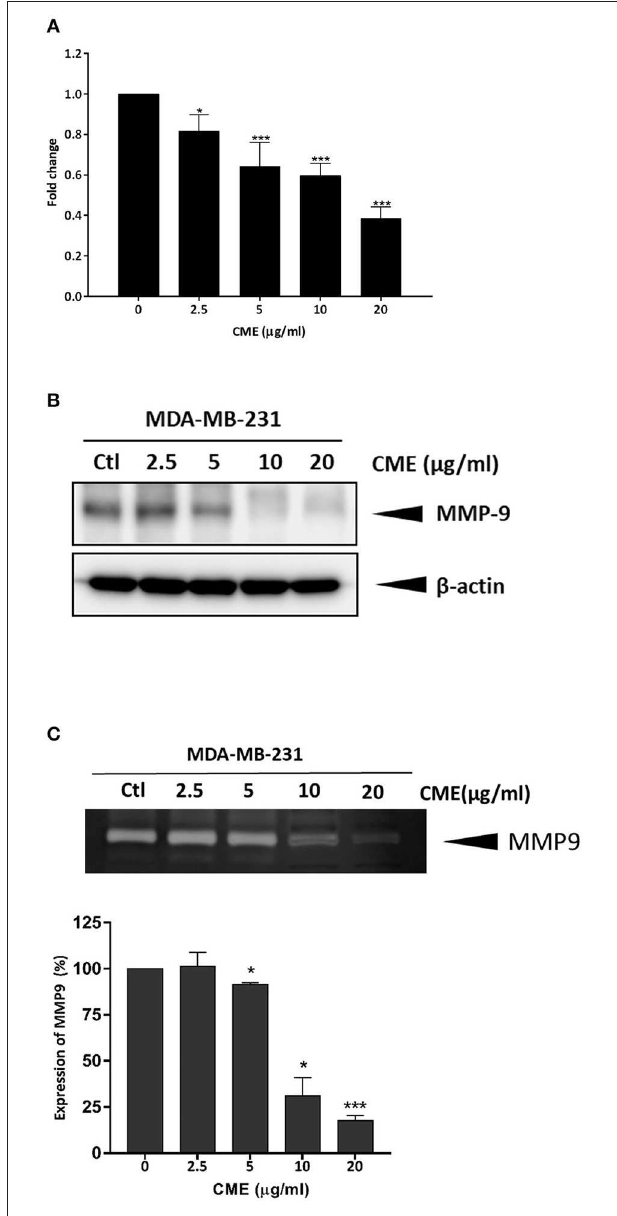
FIGURE 4 | Effect of CME on the expression and activity of MMP-9 in MDA-MB-231 cells. Cells were treated with various concentrations (0, 2.5, 5, 10, and 20 µ g/ml) of CME for 48h. Cell pellets and the conditioned serum-free medium were collected. (A) qPCR assessment of the mRNA expression of MMP-9. (B) Western blot assessment of the protein expression of MMP-9. (C) Gelatin zymography was employed to analyze the activity of MMP-9. Activity of MMP-9 was quantified by densitometric analysis. Results are presented as the means ± SD from three independent experiments. * P < 0.05 and *** P < 0.001 vs.